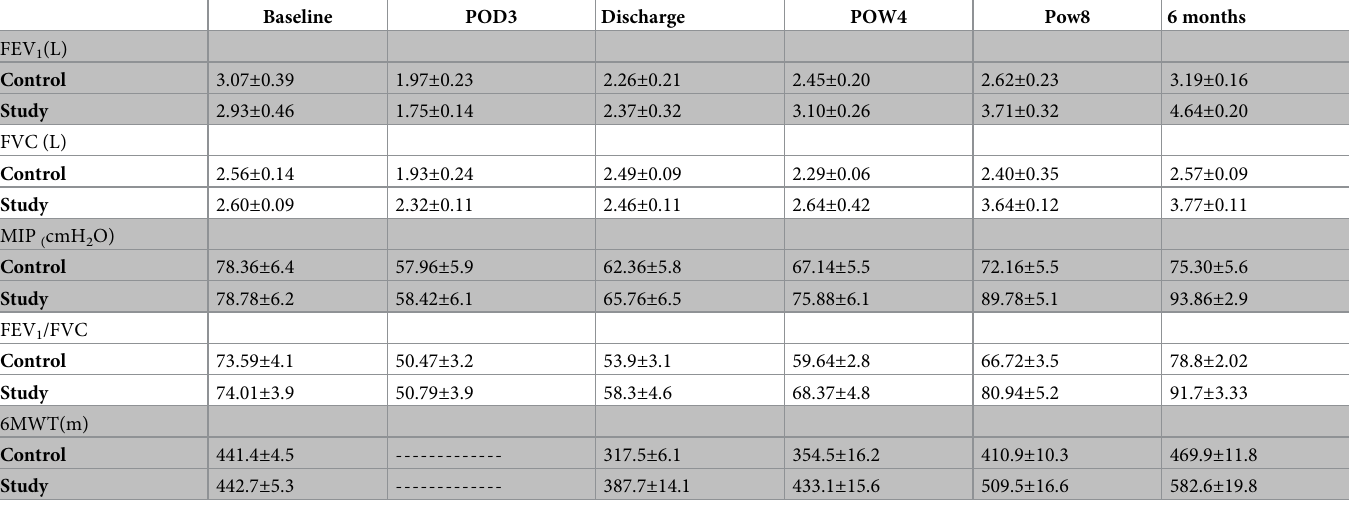
Table 2. Descriptive statistics for pulmonary function measures and functional capacity over time for both study and control